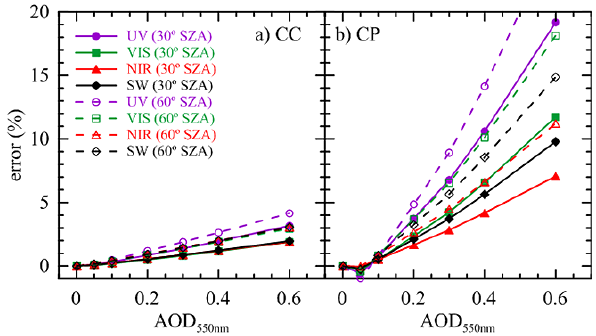
Figure A1. Dependence on aerosol load of the error committed when the optical properties are fixed in the different spectral ranges for two SZAs (30 ◦ solid lines and symbols, and 60 ◦ dashed lines and open symbols), and (a) continental clean (CC) and (b) conti- nental polluted (CP)